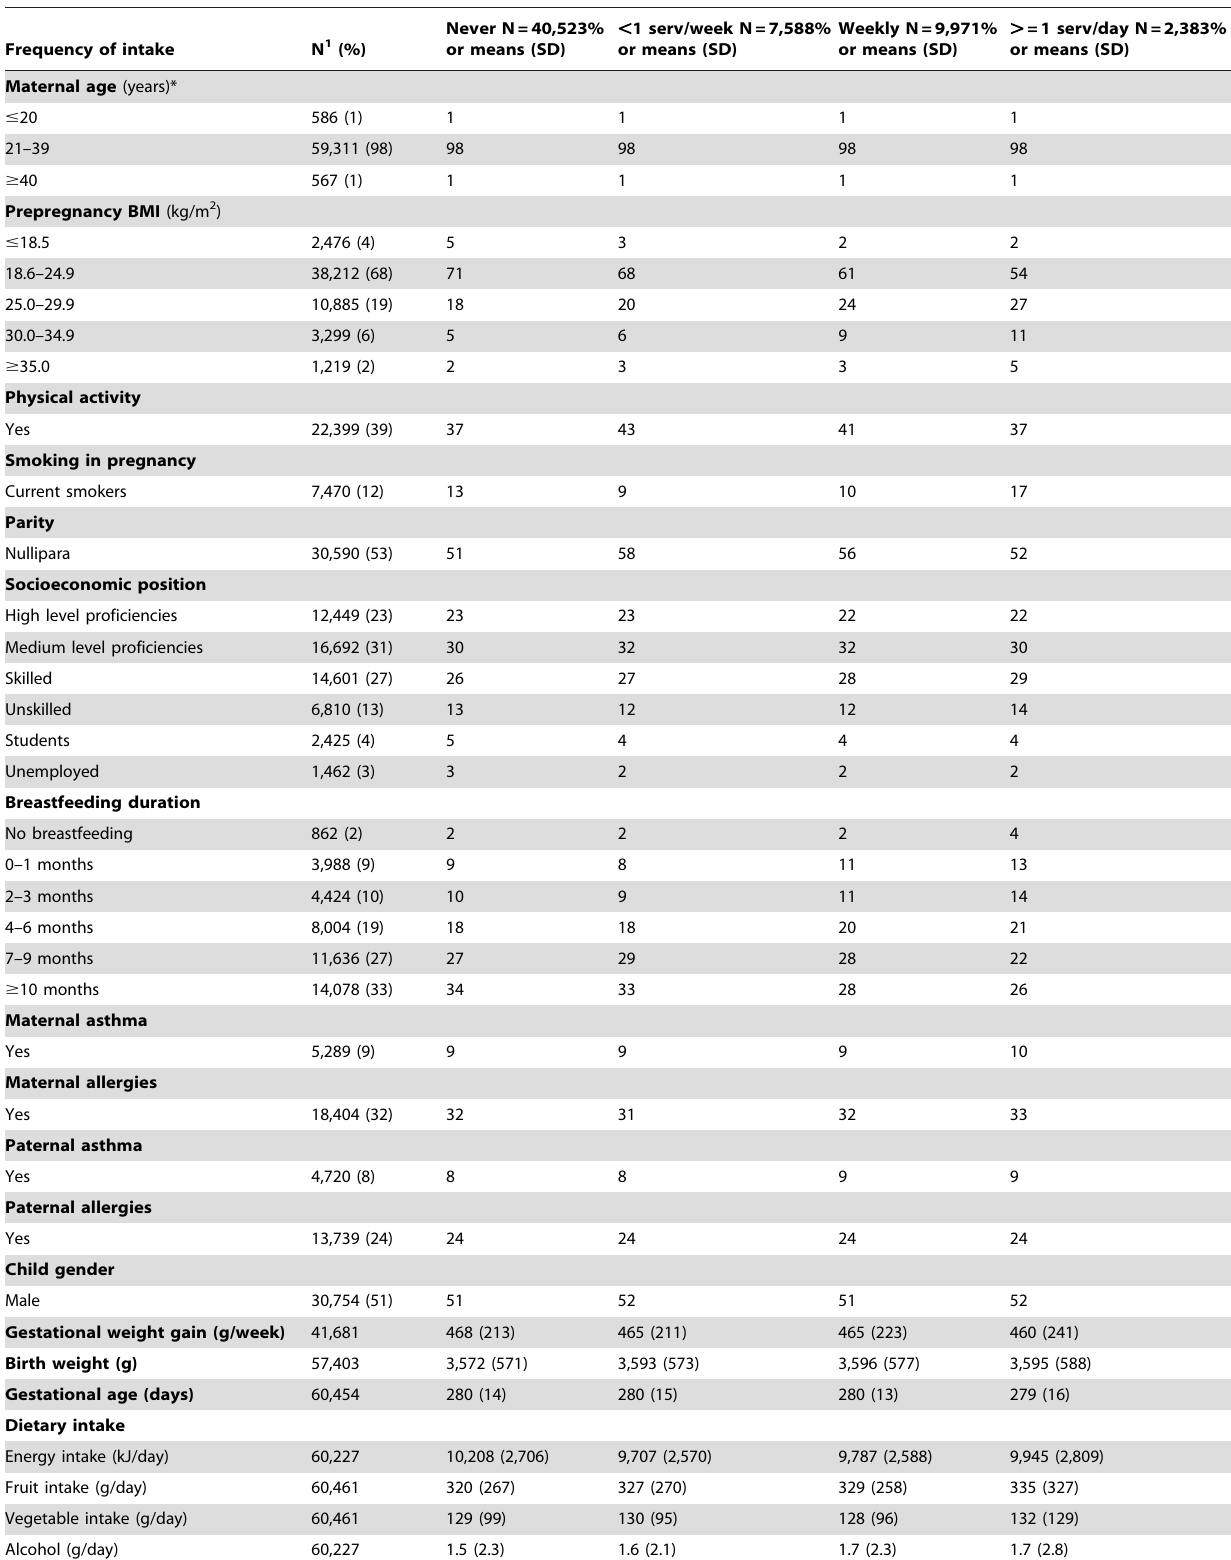
Table 1. Age-standardized covariate distribution across categories of maternal consumption of artificially-sweetened carbonated soft drinks during pregnancy, N=